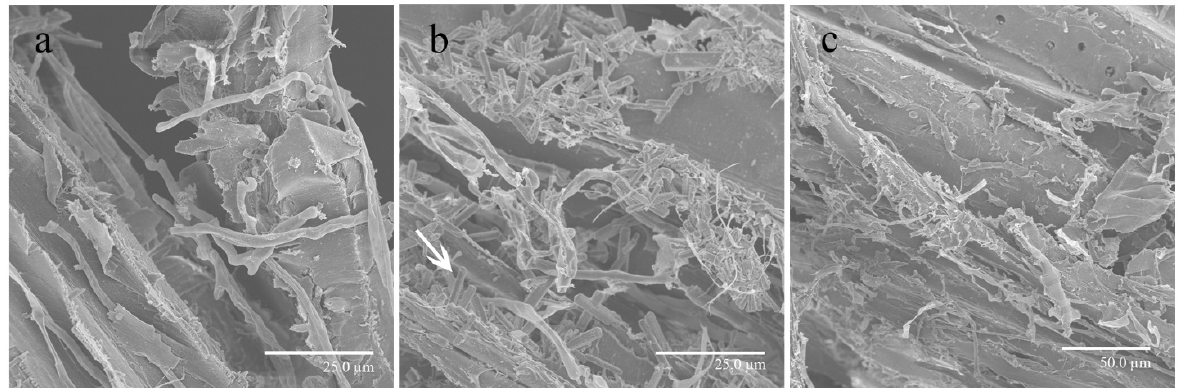
Figure 7. Distinguishing features of pine sawdust degraded by S. latifolia . ( a ) Pine sawdust collected from PSM; ( b ) pine sawdust collected from PSM supplemented with 10 mM OA, and mostly intact fibers; some bound macrofibrils and large numbers of crystals can be seen; ( c ) pine sawdust collected from PSM supplemented with 4 mM OA - . Crystal is indicated with white arrowhead.